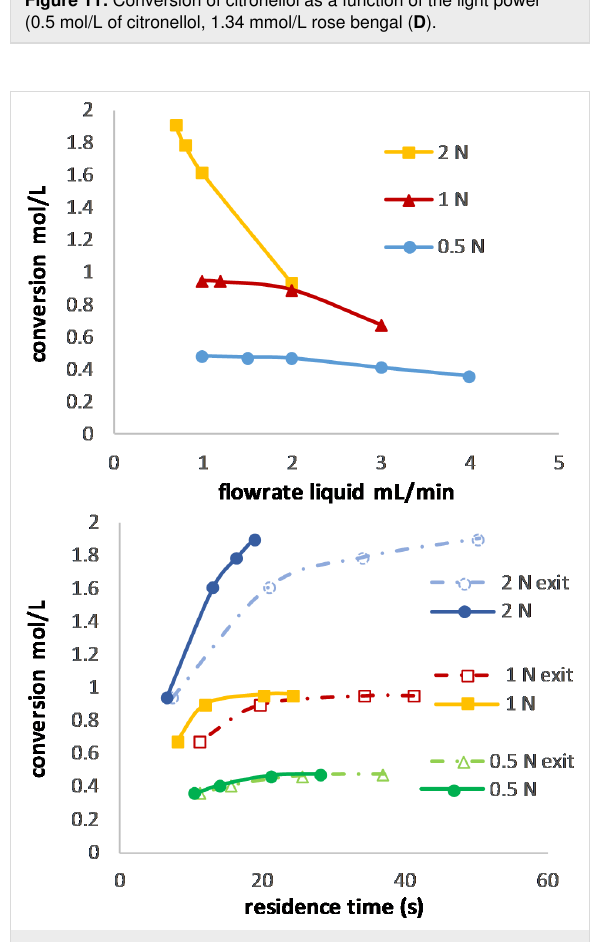
Figure 12: Absolute conversion of various concentrations of alpha- terpinene at 407 nm using 0.32 mmol/L of TPP ( H ) as a function of the liquid flow rate (top) and the residence time